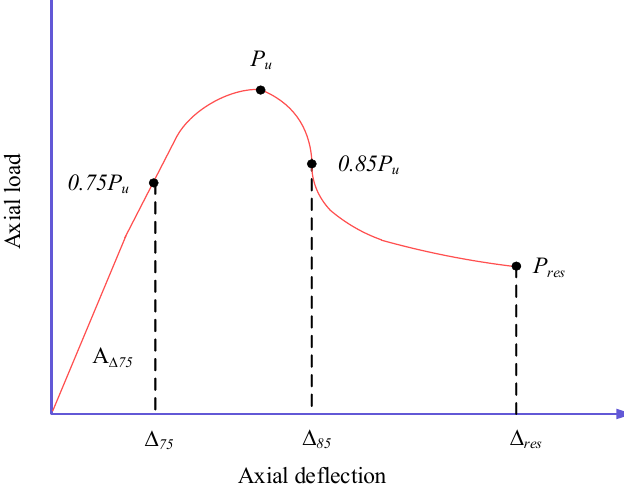
Figure 11 . Ductility index measurement for specimens. Figure 11. Ductility index measurement for